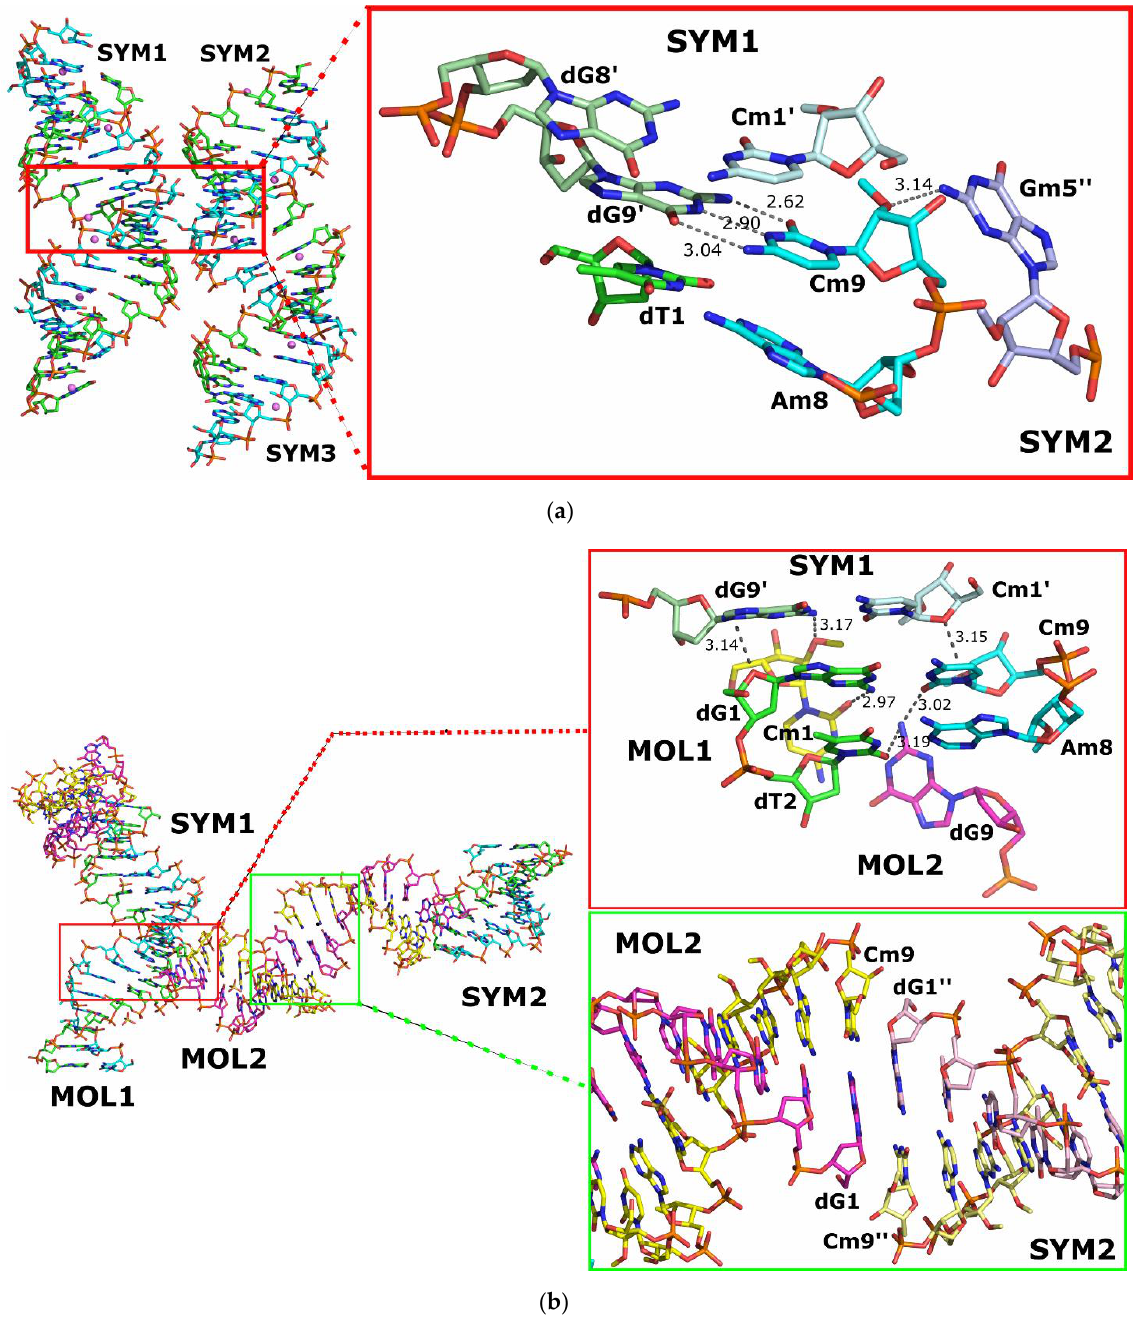
Figure 5. Intermolecular interactions: ( a ) between an overhanging reference DNA: 2′ -OMe-RNA du- plex and a symmetry-related object SYM1; ( b ) between blunt-ended reference DNA: 2′ -OMe-RNA duplexes and symmetry related objects SYM1 and SYM2. Hydrogen bonds are indicated by dark grey dashed lines.